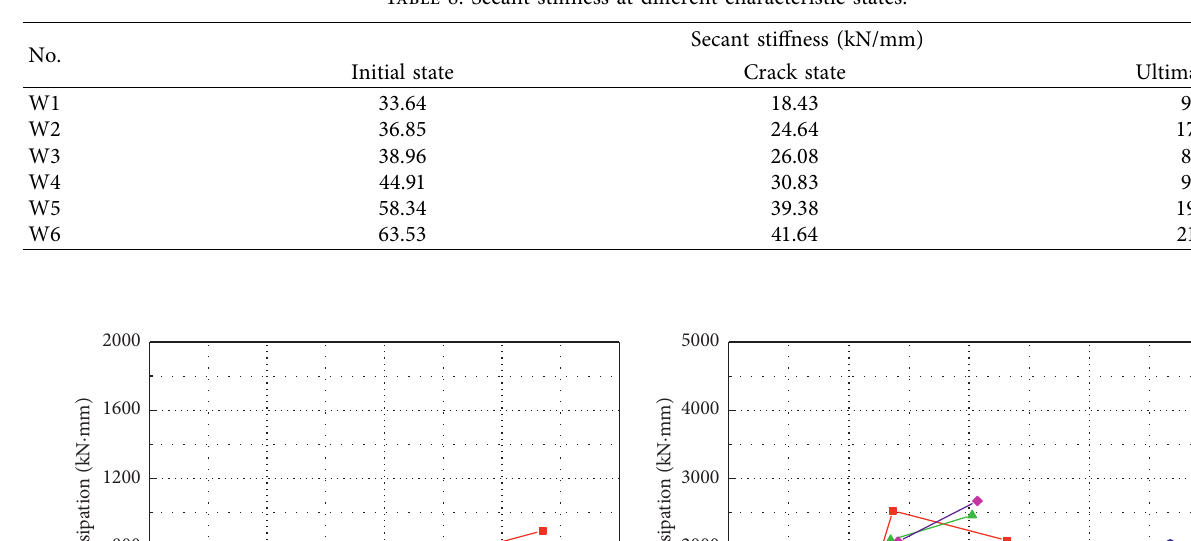
Figure 11: Stiffness degradation of the specimens: (a) W1 and W2; (b) W3–W6. Table 8: Secant stiffness at different characteristic states.